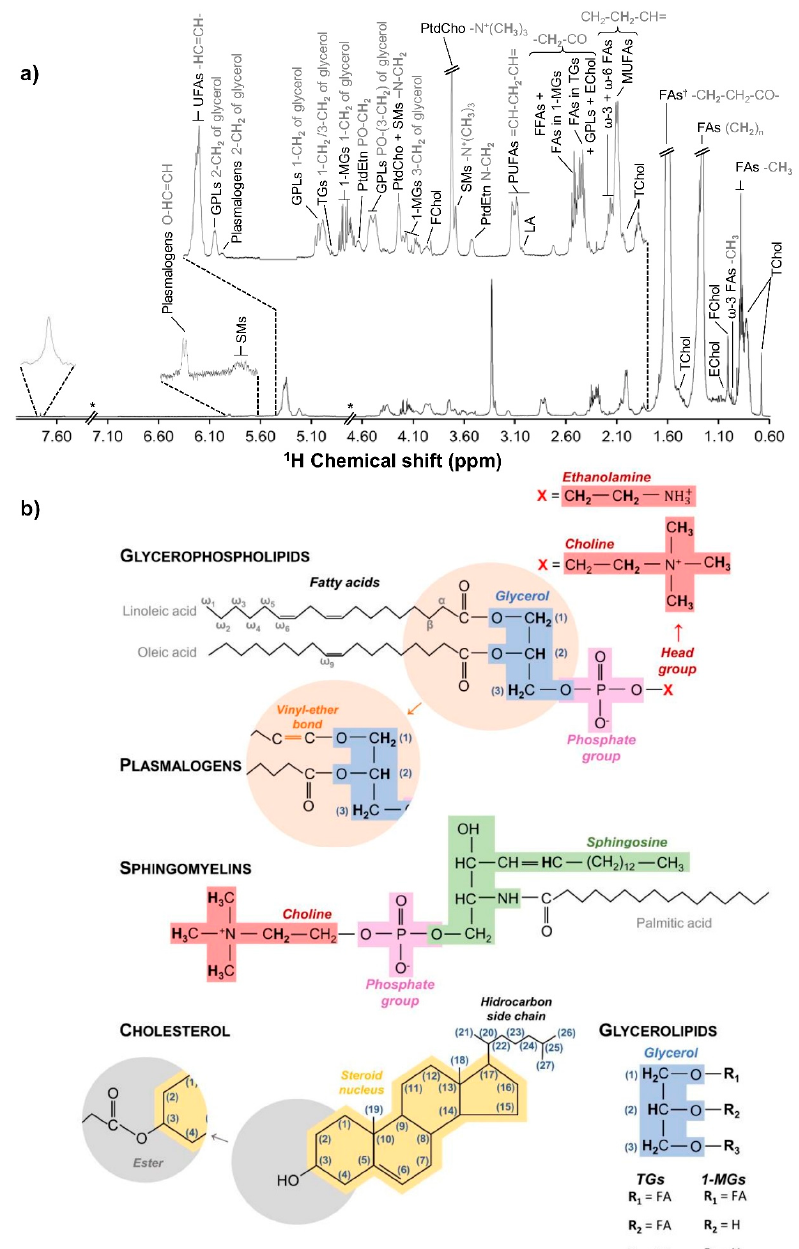
Figure 2. Lipidic profile of human adipose-derived mesenchymal stem cells (hAMSC). ( a ) Typical 1 H NMR spectra (500 MHz) of lipidic extracts from undifferentiated hAMSC prior to osteogenic medium exposure. *: exclusion of a broad unassigned signal ( δ 4.8–4.6) and chloroform ( δ 7.5–7.0) resonances; † : due to overlapping with residual water, the peak assigned to -CH 2 -CH 2 -CO- of FAs ( δ 1.8–1.4) was not considered for any statistical analysis. ( b ) Chemical structures of representative lipid species from the main families here identified, namely glycerophospholipids (including plas- malogens), sphingomyelins, cholesterol (free and esterified), and glycerolipids (TGs and 1-MGs). Protons in bold correspond to those assigned in the NMR spectra. Supplemental Table S1 shows the complete list of assigned signals. 1-MGs, 1-monoacylglicerides; EChol, esterified cholesterol; FAs, fatty acids; FChol, free cholesterol; FFAs, free fatty acids; GPLs, glycerophospholipids; MUFAs, mo- nounsaturated fatty acids; PtdCho, phosphatidylcholine; PtdEtn, phosphatidylethanolamine; PUFAs, polyunsaturated fatty acids; SMs, sphingomyelins; TChol, total cholesterol; TGs, triacylglycerides; and UFAs, unsaturated fatty